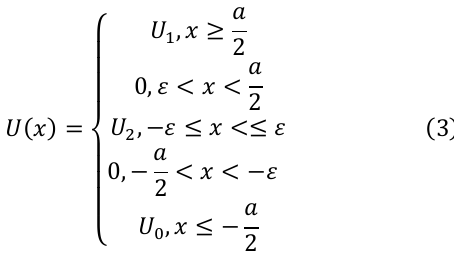
version with uneven walls and internal potential